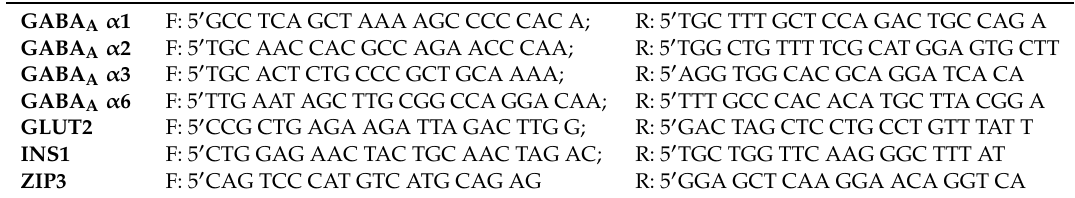
Table 1. Primer sequences used for quantitative